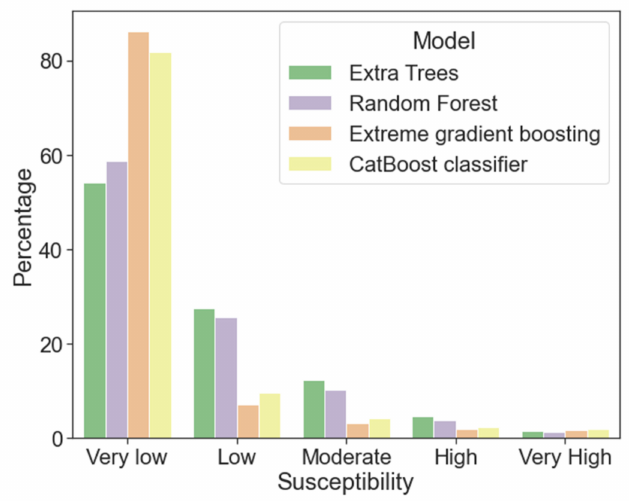
Figure 10. Area percentage of each susceptibility